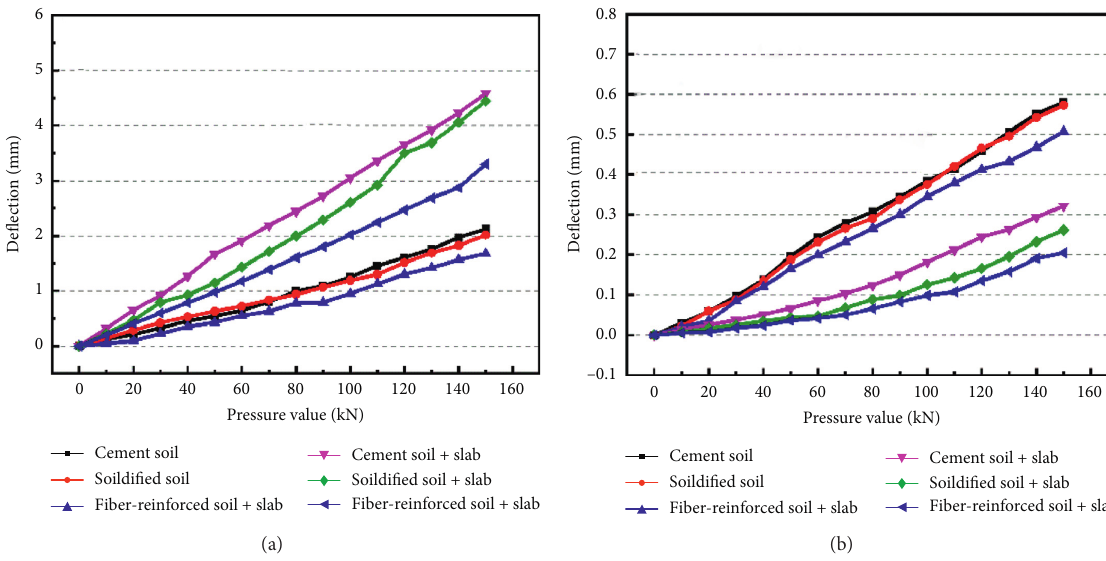
Figure 19: Variation curves for deflection of bearing plate edge with loading value. (a) After loading. (b) After unloading.